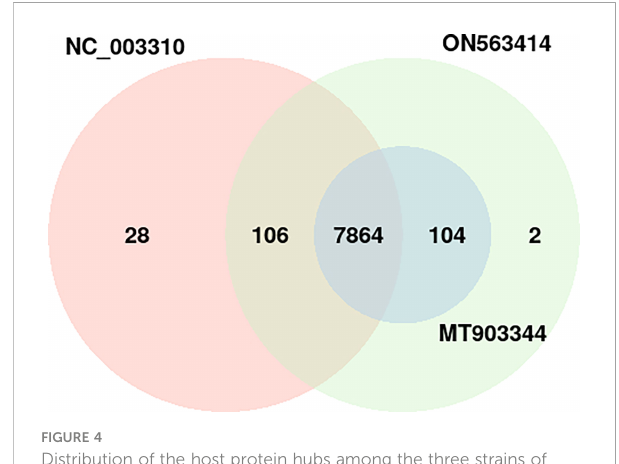
FIGURE 4 Distribution of the host protein hubs among the three strains of monkeypox virus (NC_003310, ON563414, and MT903344). p -value of the overlap region is 0.